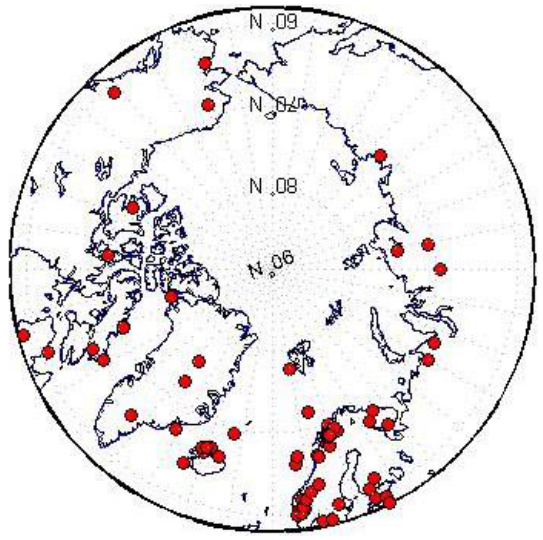
Fig. 1. Map of the sites from which quantitative temperature and precipitation reconstructions from proxy data have been